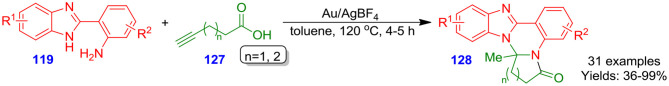
Au-catalyzed cascade method for the formation of quinazolinones.